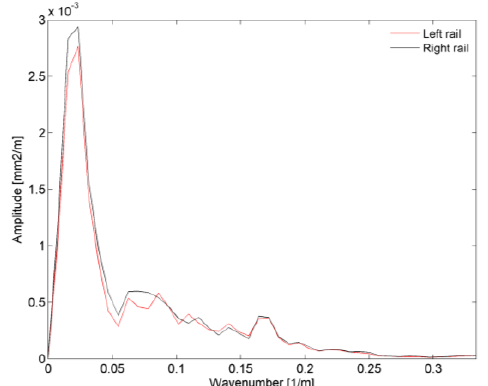
Figure 6. Amplitude of the power spectra of the irregularities, as a function of the wave number, on the left and right rails.